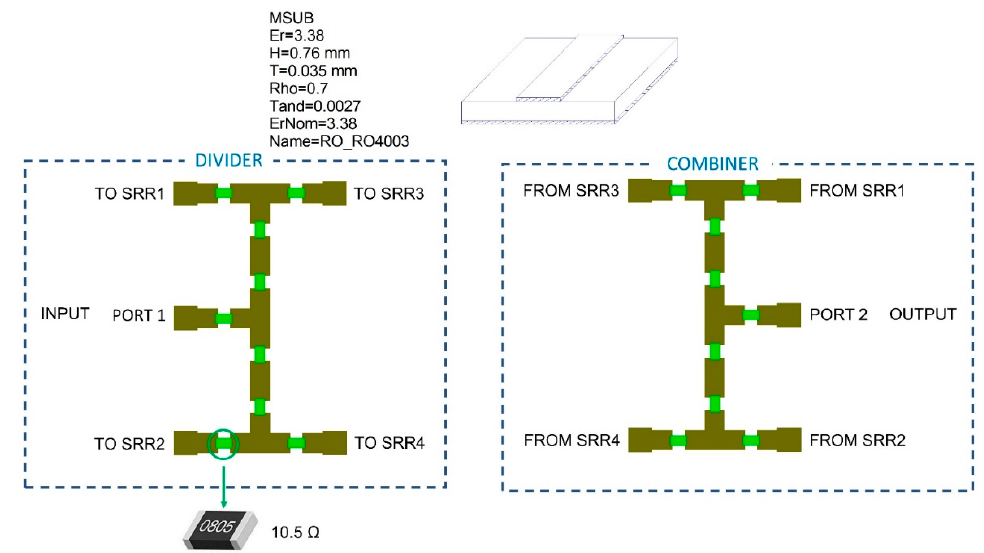
Figure 4. Scheme of the network with the MWO schematic of the power divider and combiner.